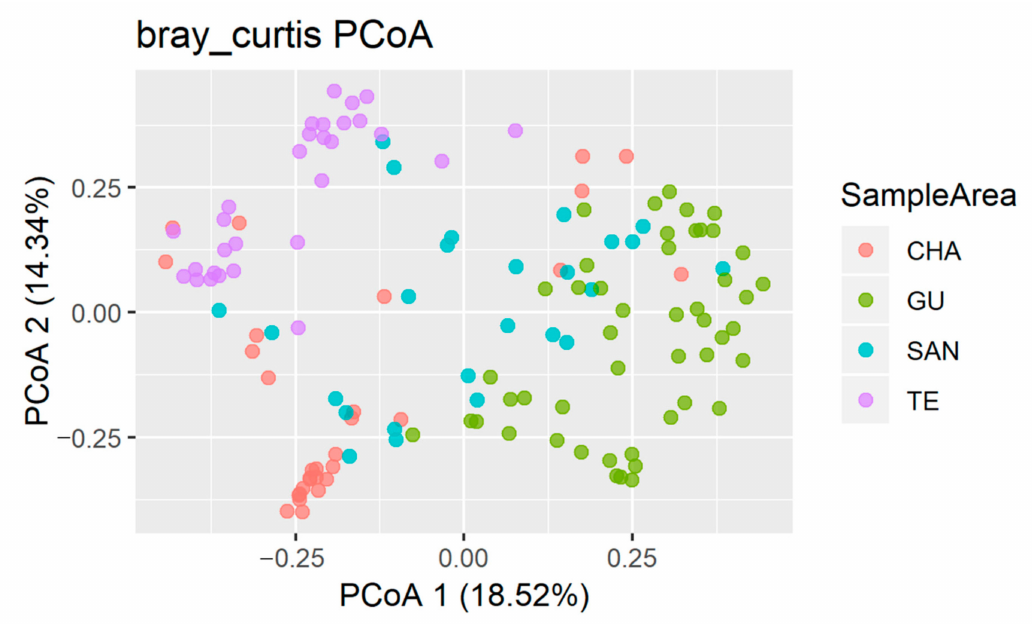
Figure 3. Principal Co-ordinates Analysis (PCoA) of four sampled meadows. The PERMANOVA results show that P <